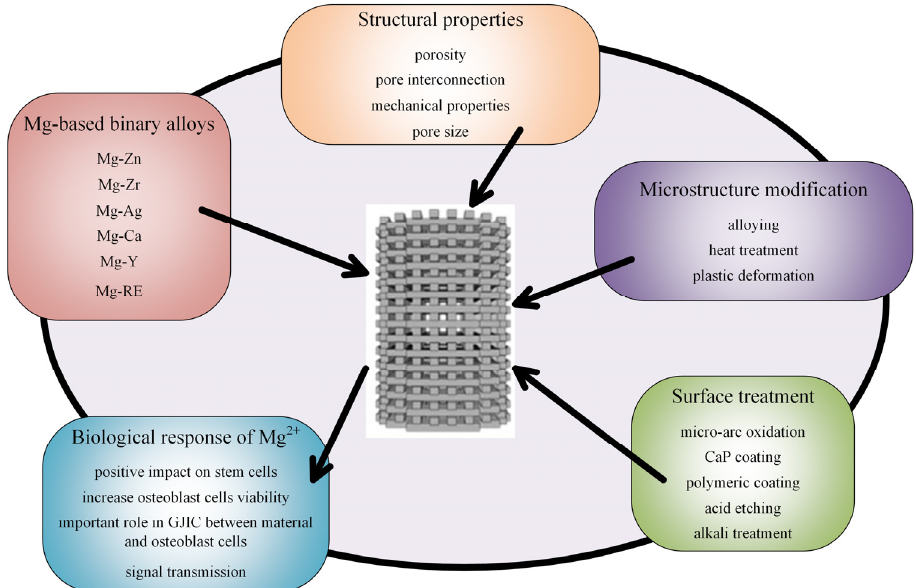
Figure 8. Type of alloys, microstructure modifications, surface treatments, and biological effects of Mg-based scaffolds. Mg-based